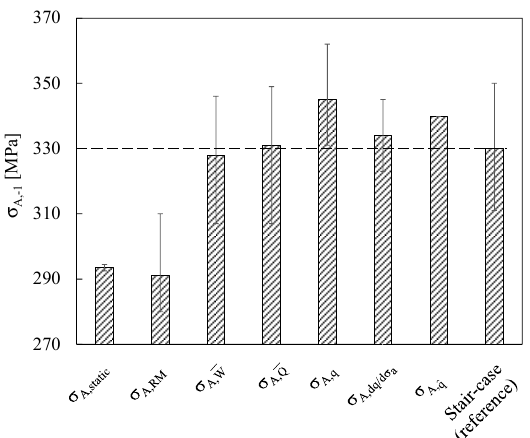
Figure 22. Comparison among the fatigue limits σ A, − 1 calculated according to di ff erent experimental approaches.